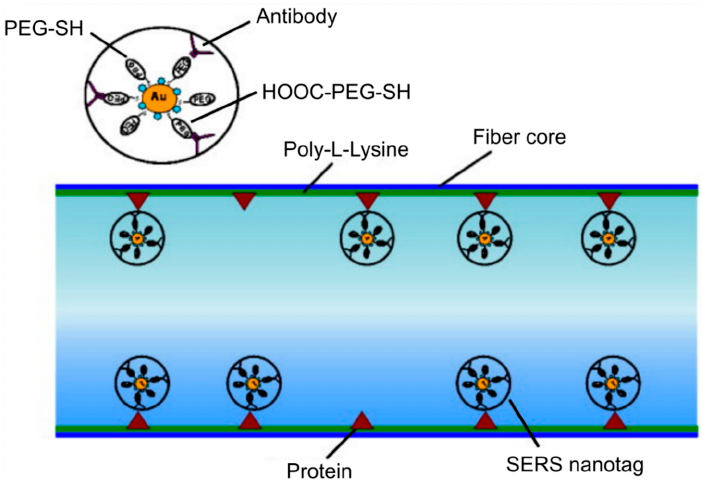
Figure 8. Sketch of the functionalized fiber surface showing the binding of anti-epidermal growth factor receptors (anti-EGFR) antibody conjugated surface-enhanced Raman scattering (SERS) nanotag to the cancer protein (positive human epithelial carcinoma cells A431) immobilized on the inner wall of the core of MOF. Reproduced with permission from [14].